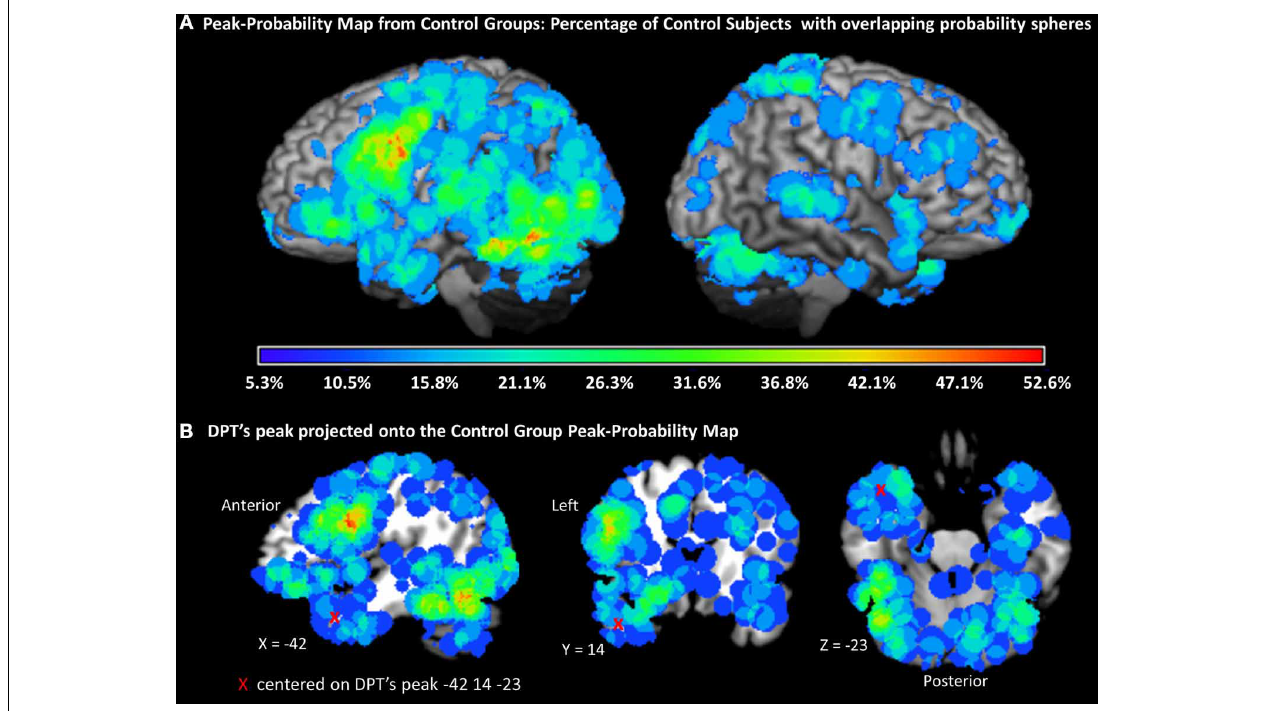
FIGURE 6 | Peak probability map (PPM). (A) Map of probability spheres each with a radius of 1 standard deviation of the UD (uncertainty distance), centered on each individual participant control peak and projected onto a standard rendered template brain. The color scale represents the percentage